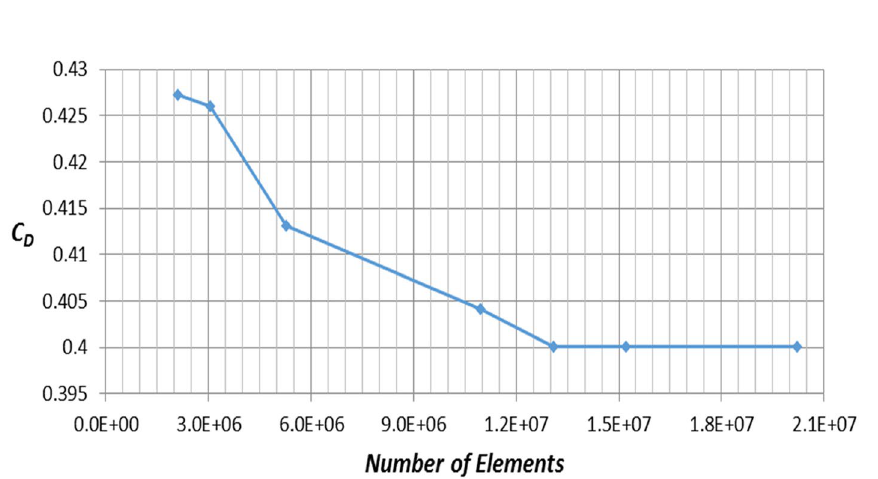
Figure 10. Grid independence for realizable k – ε